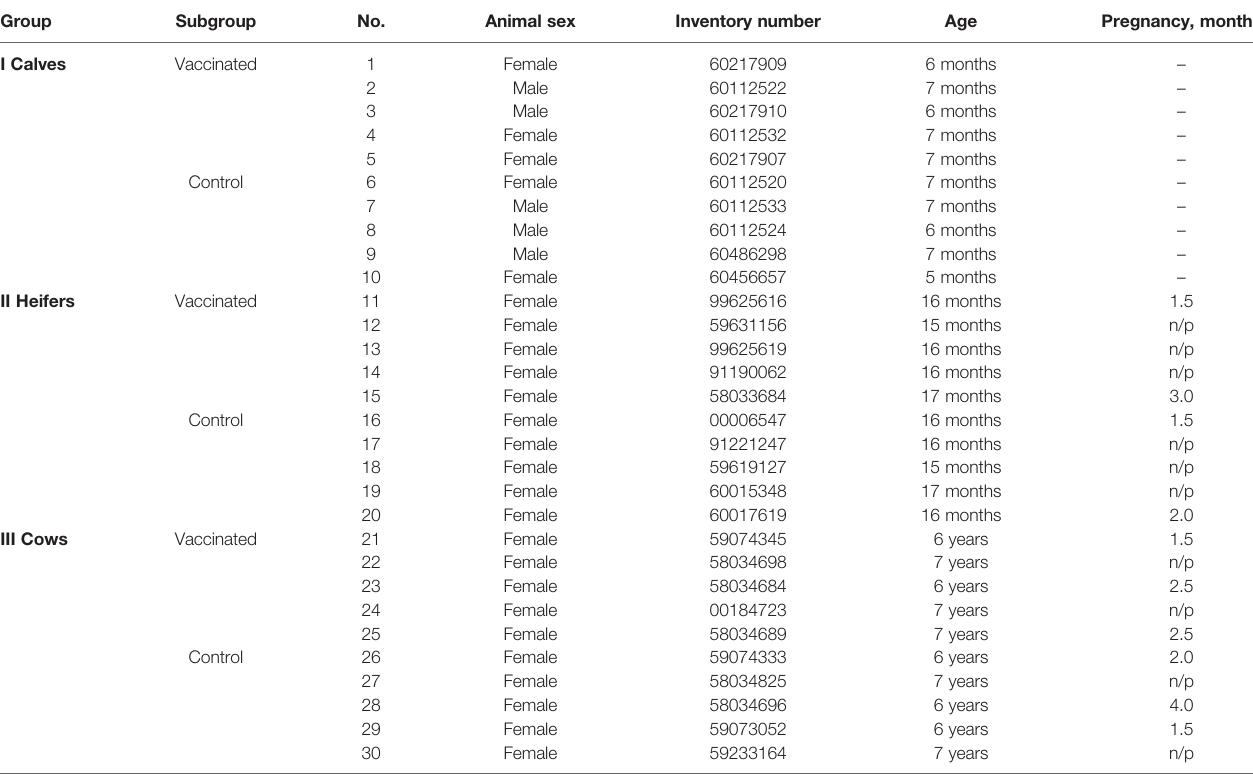
TABLE 1 | Randomized cattle